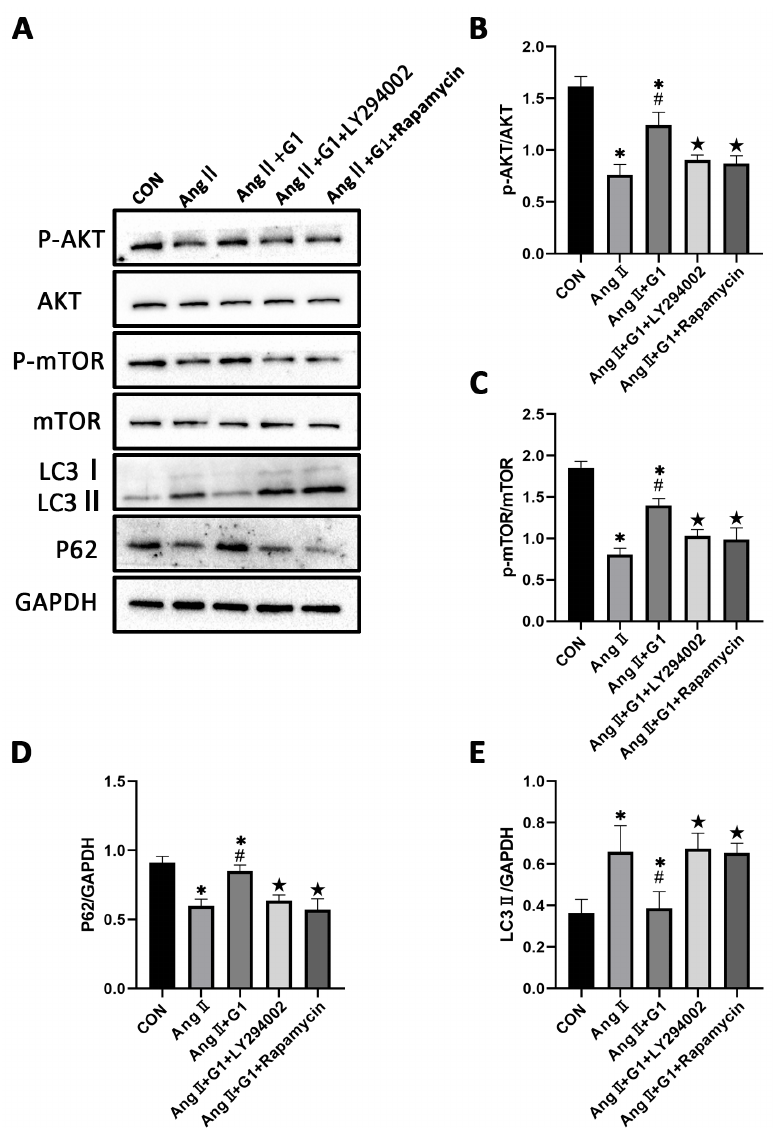
Figure 9. LY294002 or rapamycin blocks the effect of G1 on autophagy induced by AngII in H9c2 cells. ( A ) Representative images of Western blots in Con, AngII, AngII + G1 and AngII + G1 + LY294002, and AngII + G1 + Rapamycin groups. ( B ) p-AKT/AKT ratio, ( C ) p-mTOR/mTOR ratio, ( D ) LC3II/GAPDH, and ( E ) P62/GAPDH from indicated groups. The data is expressed as mean ± SEM and was analyzed by one-way ANOVA (n = 3). * p < 0.05 vs. Con; # p < 0.05 vs. AngII; (cid:70) p < 0.05 vs. AngII +